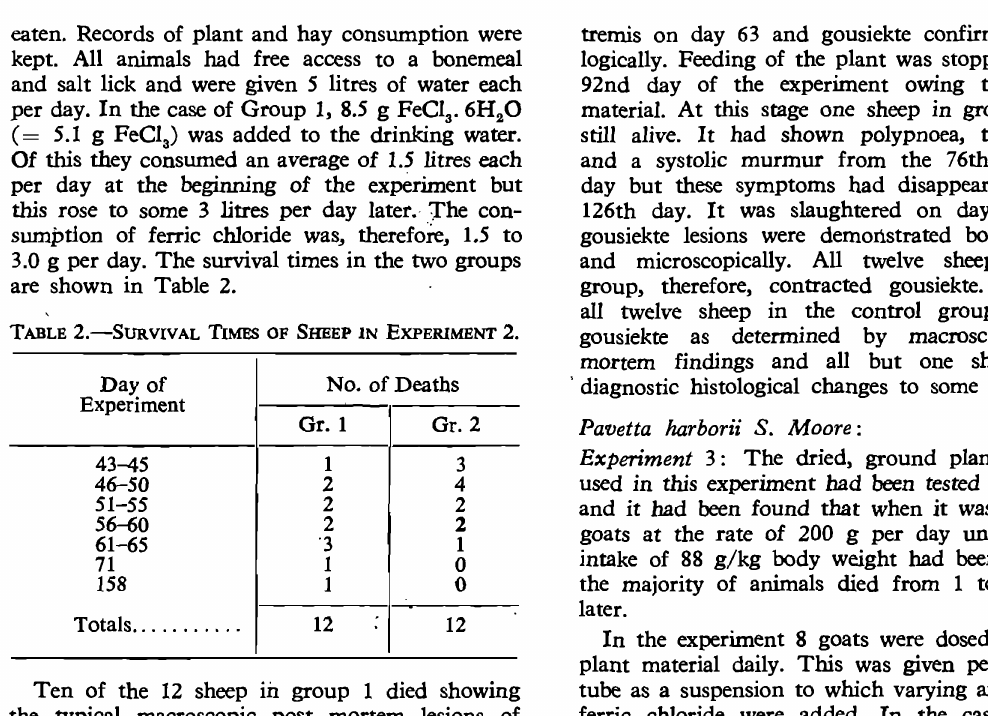
TABLE 3.-PAVETI'A HARBORlI S.